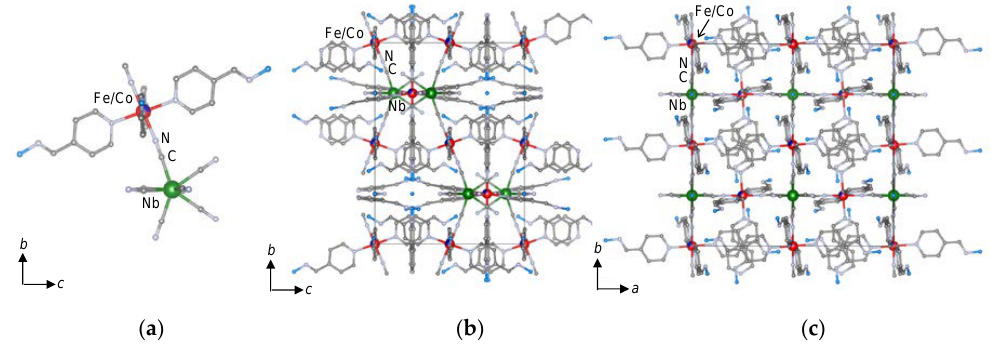
Figure 3. Crystal structure and coordination geometries around the metal centers for 3 . ( a ) Coordination geometry around the metal centers; ( b ) crystal structure viewed from the a -axis; and, ( c ) from the c -axis. Water molecules are omitted for clarity.